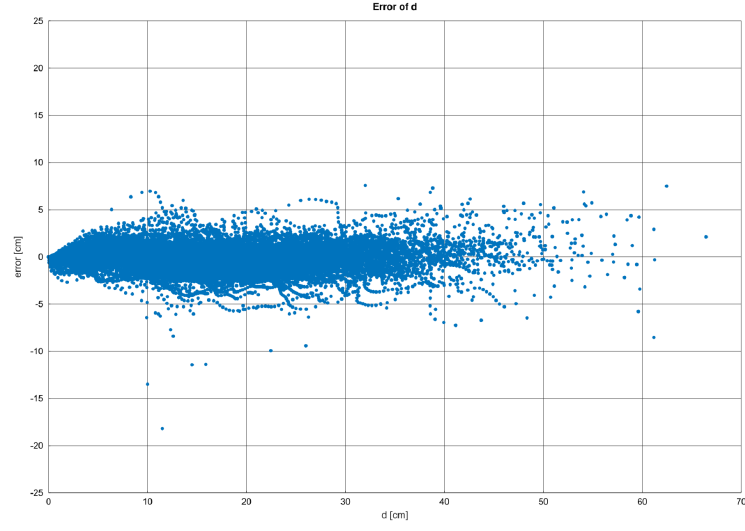
Figure 3. Residuals versus fitted values for Kozak’s model for pine.